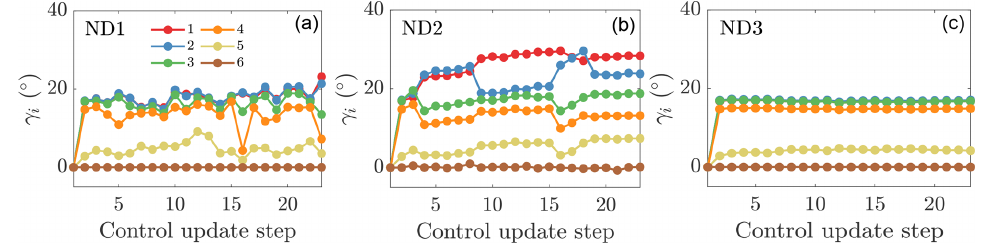
Figure 14. Yaw misalignment angles for each turbine in the wind farm for (a) online control using the initial parameters to initialize the next state (ND1), (b) online control using the previous optimal parameters to initialize the next state (ND2), and (c) the static state estimation control (ND3).